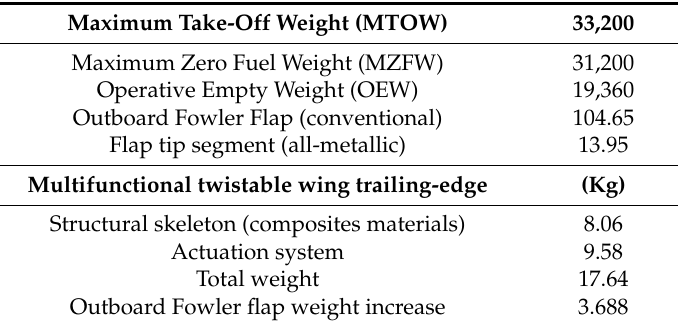
Table 4. Regional Turbo-Prop aircraft (90